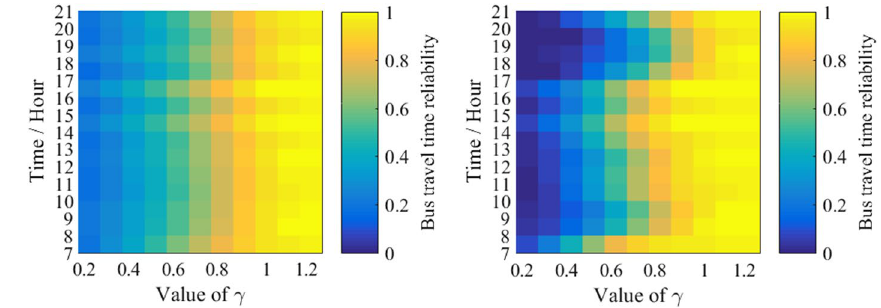
Fig. 16 Bus travel time reli- ability in different travel time